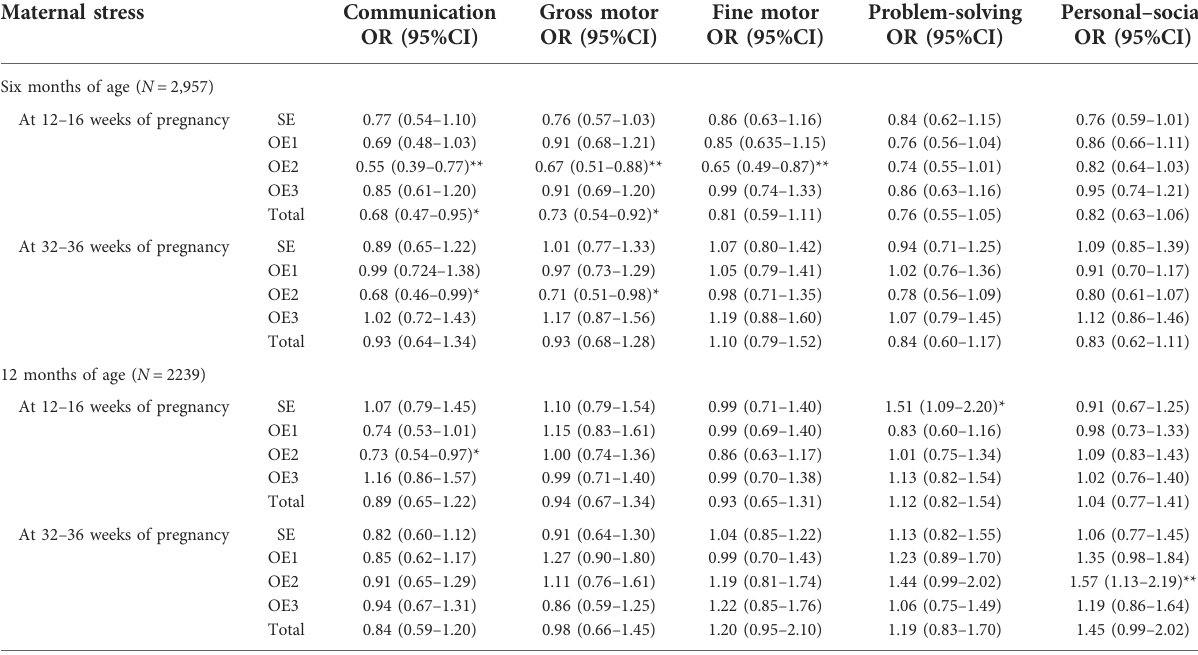
TABLE 2 Multivariate logistic regression analysis of the association between maternal psychological stress and neurodevelopment in infants (model I). Maternal stress Communication Gross